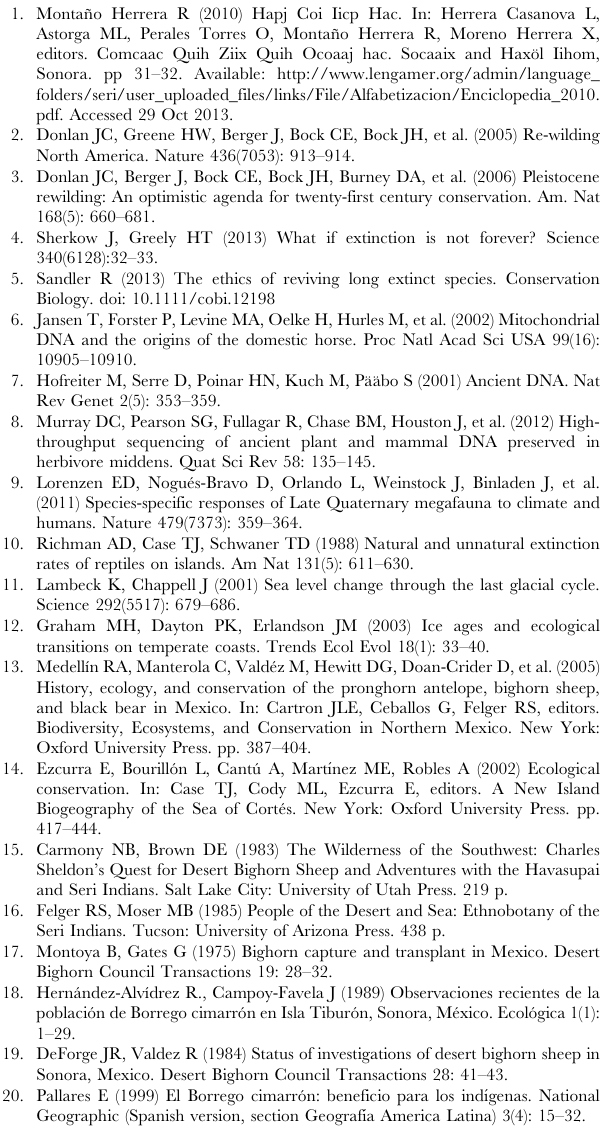
Table S1 Primer sequences and fragment size. The genes sequenced or attempted from ancient fecal pellets from Tiburo´n Island, Mexico. Table S2 Accession numbers of sequences used. The sequences used for primer development and sequence alignment for reference sequences and ancient fecal DNA of unknown origin from Tiburo´n Island, Mexico. (PDF) Video S1 Movie of Mojet Cave, Tiburo´n Island. The video shows the fossil dung mat as encountered before any sampling or manipulation was made. Taken by Wilder 29 Mar 2012, featured in the video (in order of appearance)